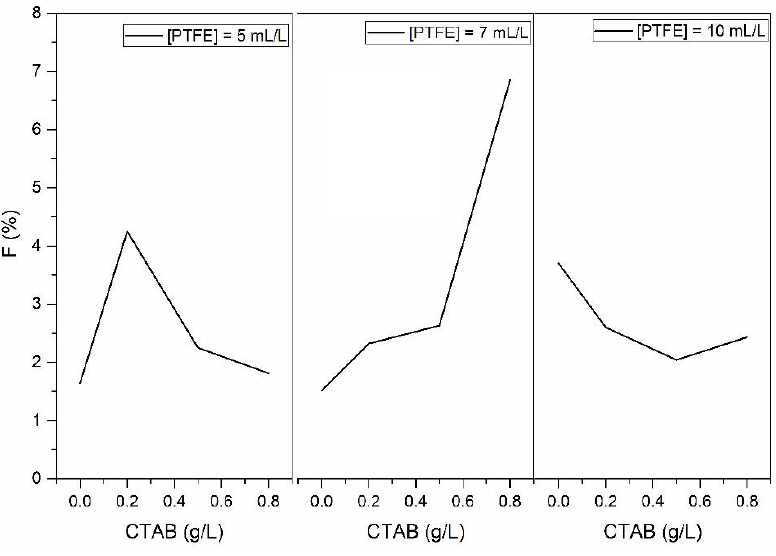
Figure 3. Fluorine content in the Ni-P-PTFE films presented in Figures 1 and